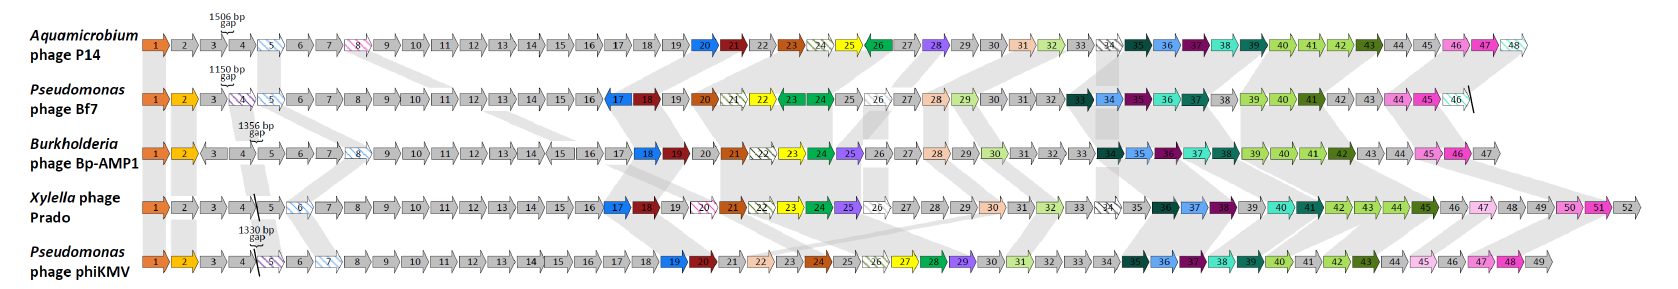
Figure 3. Genomic organization of the Aquamicrobium phage P14 compared to the Pseudomonas phage Bf7 (NC_016764.1), the Burkholderia phage Bp-AMP1 (HG793132.1), Xylella phage Prado (NC_022987.1) and Pseudomonas phage phiKMV (NC_005045.1). Coding sequences encoding proteins with similar functions are colored in the same color. Hypothetical proteins are marked by diagonal lines. A match between the proteins was either defined by similarity of the amino acid sequences (blastx hits with E-value < 0.00001) or proteins with the same function as defined in their